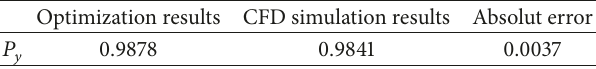
Table 9: Comparison of the results of the optimized data and CFD simulation.